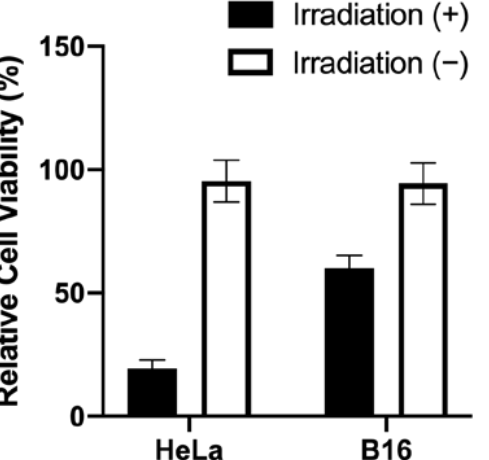
Figure 7. Cytotoxicity against HeLa (BR+) and B16 (BR − ) cells with and without irradiation (20 J·cm − 2 ) after incubation with 2.0 µM Ce6-biotin for 24 h.